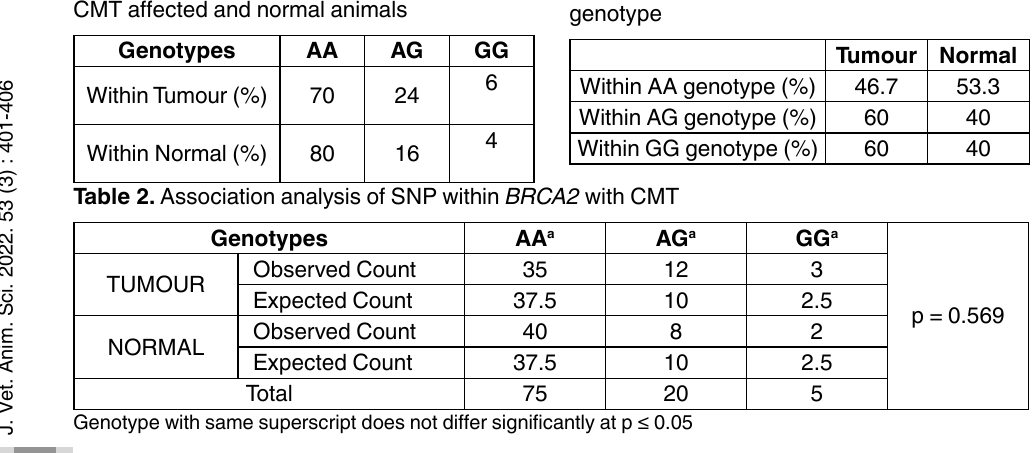
table 4 . Status of CMT within different